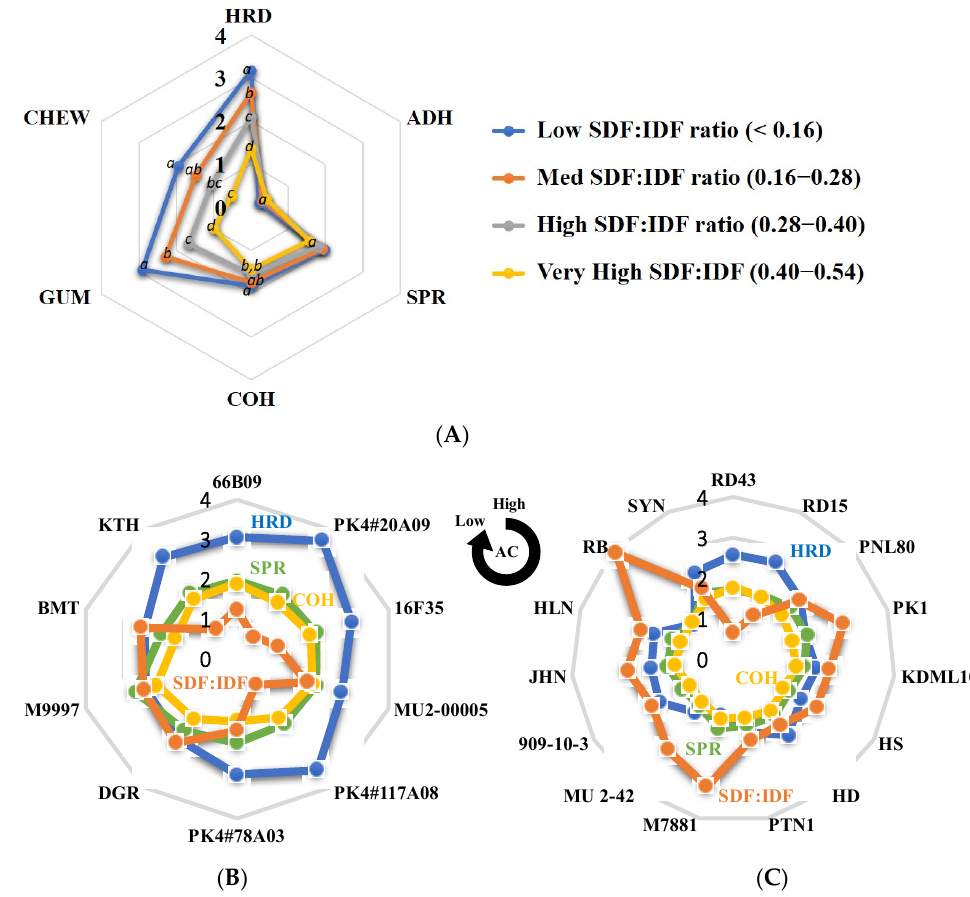
Figure 6. Radar charts showing ( A ) textural characteristics of whole grain rice containing different SDF:IDF ratios and ( B , C ) relationships between textural properties and dietary fibre profiles of ( B ) whole grain Wx a rice with AC higher than 20% and ( C ) whole grain Wx b rice with AC lower than 20%. Rice varieties are sorted in a clockwise direction from high to low AC. The texture parameters including hardness (HRD), adhesiveness (ADH), springiness (SPR), cohesiveness (COH), gumminess (GUM) and chewiness (CHEW), and SDF to IDF ratio were expressed as a 4 ‐ point scale. Values with different letters are significantly different with p < 0.05.